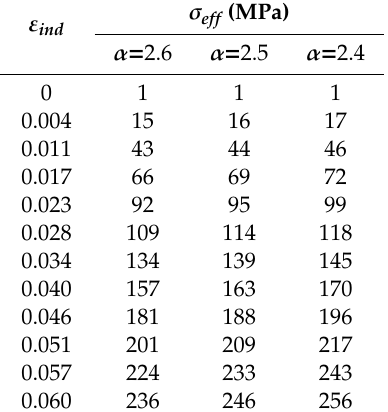
Table 1. E ff ective indentation stress and indentation strain with di ff erent indentation stress constrain factor, α , at h = 5 µ m.